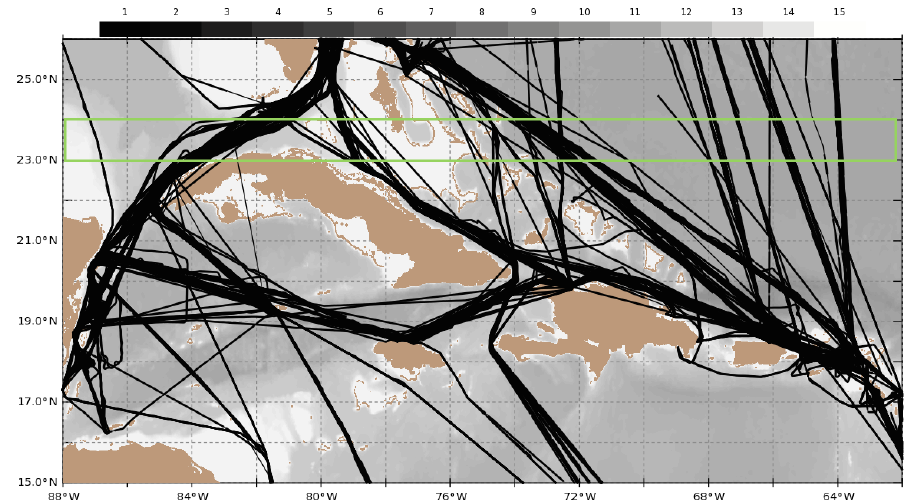
Figure 1. Map with the cruise tracks of the EoS , Eqnx and ALoS from 2002 though 2018. The gray scales show bathymetry, with white being less than 200m. The green rectangle depicts the region where the data and products are compared in Fig. 4.